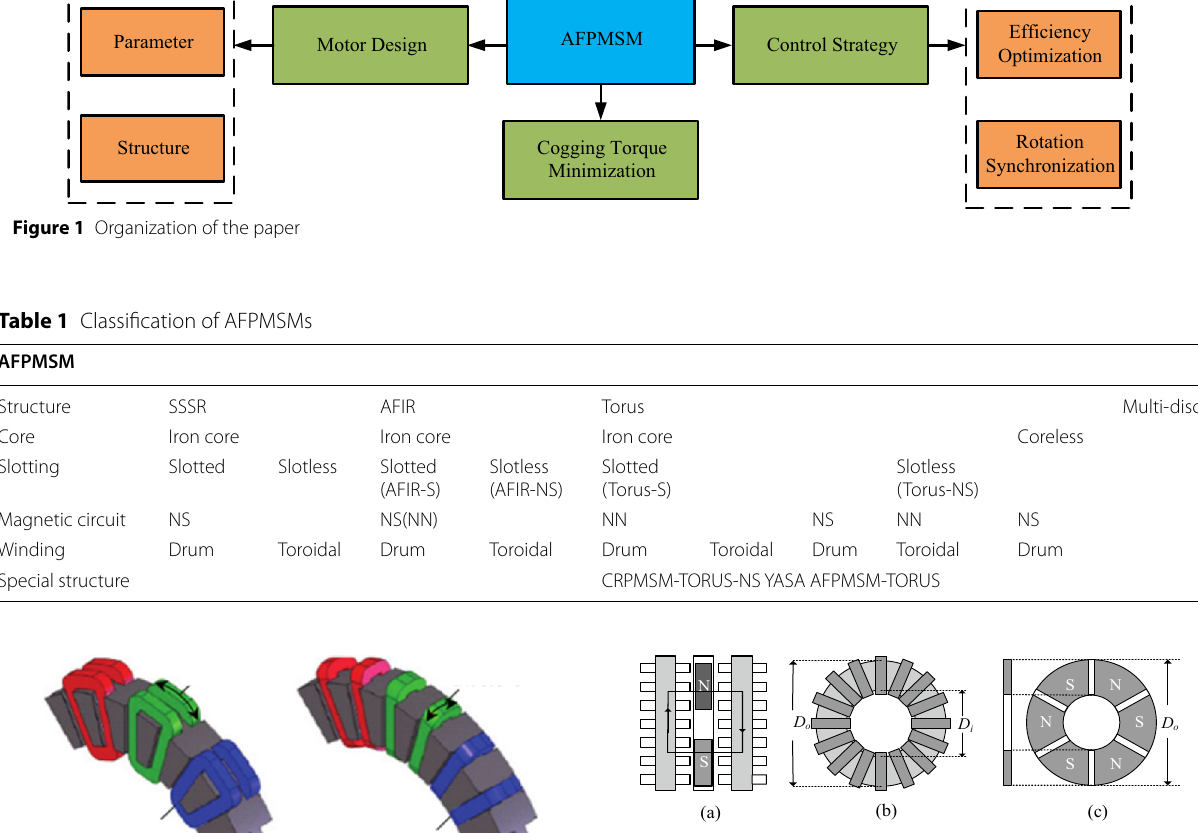
Figure 4 Sectional view of an AFIR-NS motor: a Magnetic circuit, b Stator structure, and c Rotor